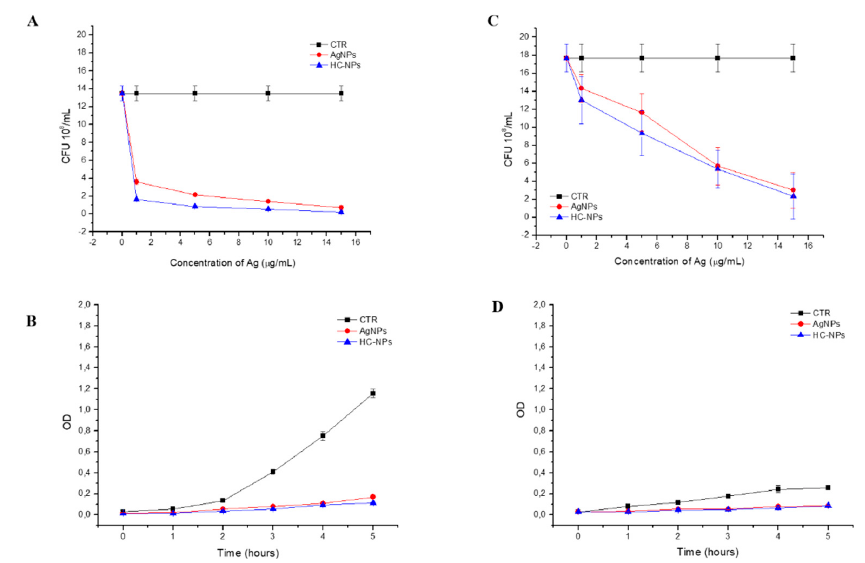
Figure 3. Antibacterial analysis on Gram-negative E. coli DH5 α ( A , B ) and Gram-positive S. aureus ( C , D ) of AgNPs and HC-NPs by colony-forming units (CFU) counting on solid Luria–Bertani (LB) broth ( A , C ) as a function of Ag concentrations after 24 h. Measurement of optical density (OD) ( B , D ) as a function of time. Representative measurements of three different sets of data have been reported ( P -values < 0.05).